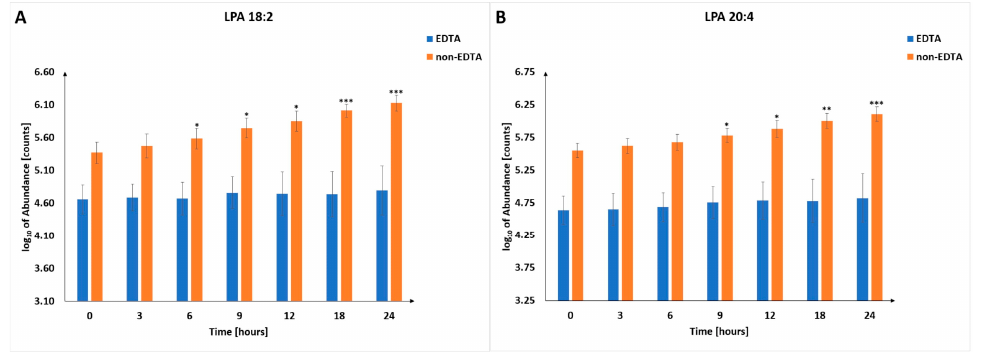
Figure 5. Changes in the level of selected lysophosphatidic acids in different postmortem time intervals. Panel ( A ) shows the trajectory for LPA 18:2, while panel ( B ) shows LPA 20:4. *— p -value < 0.05, **— p -value < 0.01, ***— p -value < 0.001.